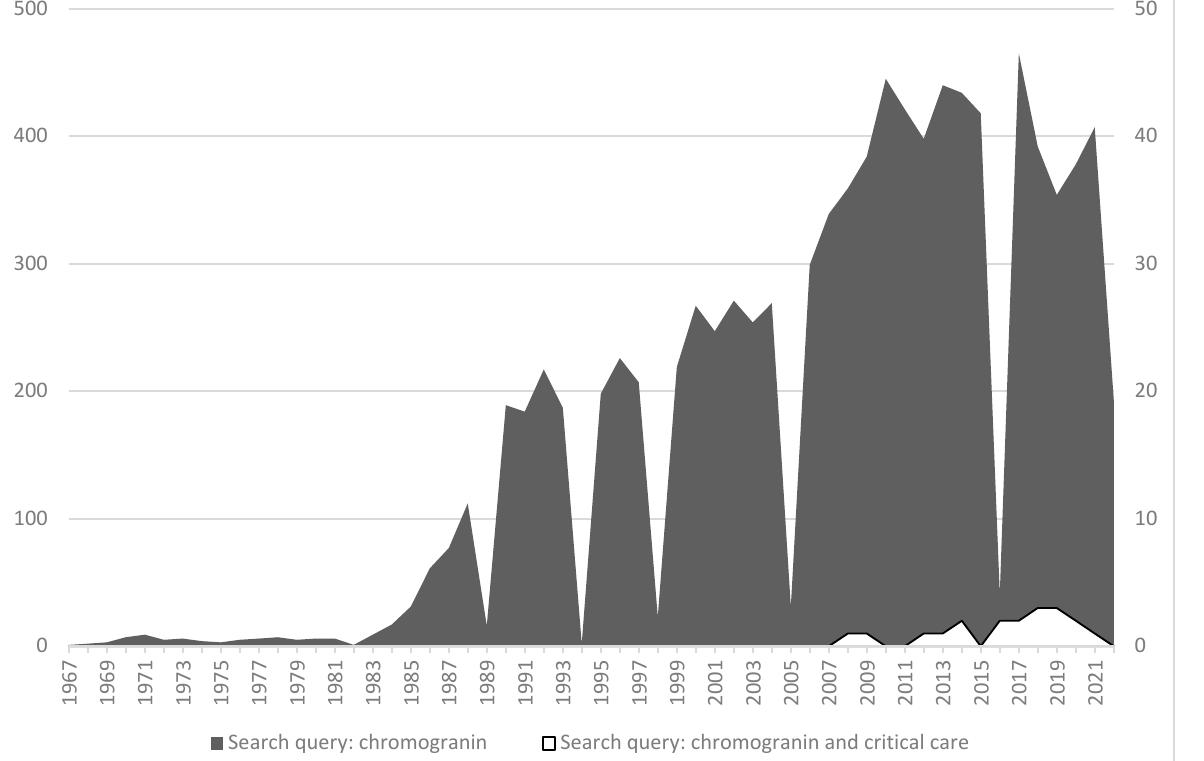
Figure 1. Number of annual papers issued in the PubMed database according to the query from 1967 to 2022. Please note that the scale of measurement is ten times larger for the query “Chromogranin” (left vertical axis) than for the query “chromogranin and critical care” (right vertical axis).